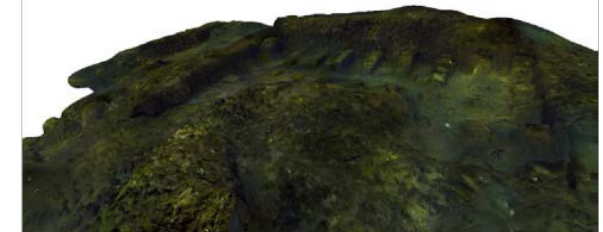
Figure 2. Final textured 3D